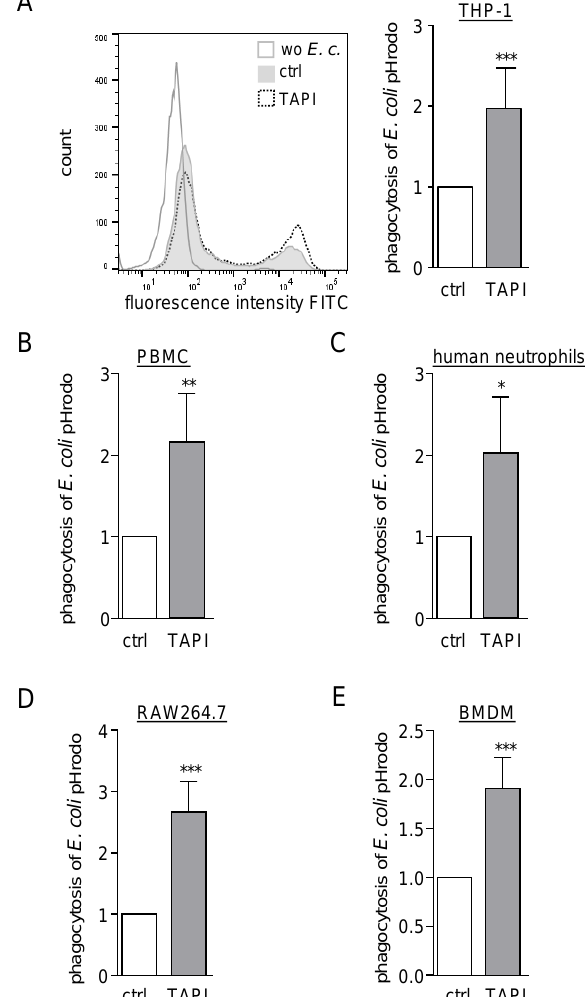
Figure 1. The a disintegrin and metalloproteinase (ADAM) inhibitor TAPI-1 increases uptake of E. coli pHrodo, ( A – E ) THP-1 cells ( A ), human peripheral blood mononuclear cells (PBMCs) ( B ), human neutrophils ( C ), murine RAW264.7 cells ( D ) and murine bone marrow-derived macrophages (BMDMs) ( E ) were preincubated with 10 µ M TAPI or 0.1% DMSO as vehicle control (ctrl), exposed to E. coli pHrodo green and assayed for phagocytosis by flow cytometry. Representative histogram overlay of the fluorescence signal from E. coli pHrodo treated and untreated (wo E. c .) THP-1 cells is shown in ( A ). The geometric mean fluorescence for each cell type was calculated in relation to that of the respective control and summarized as mean and SD of at least four independent experiments ( A ) n = 8, ( B ) n = 4, ( C ) n = 5, ( D ) n = 8, ( E ) n = 7. Significant di ff erences compared to the respective control are indicated as asterisks (* p < 0.05, ** p < 0.01, *** p < 0.001).